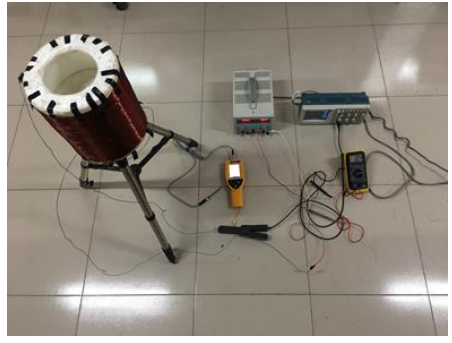
Figure 15. Experimental connection.